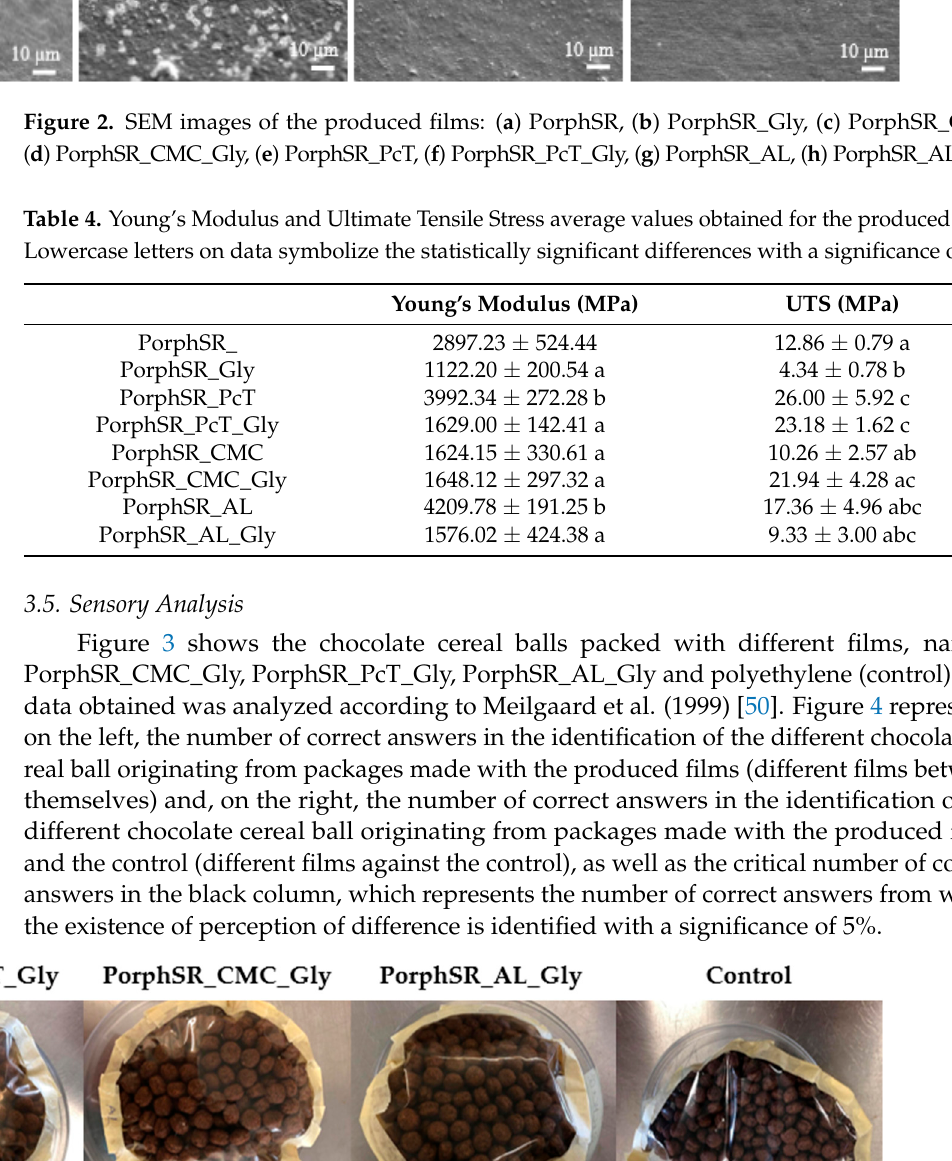
Figure 4. Number of correct answers in the differentiation through sensory analysis of cereal balls with chocolate packaged in PorphSR_PcT_Gly, PorphSR_CMC_Gly, PorphSR_CMC_Gly) and in polyethylene (control) films.